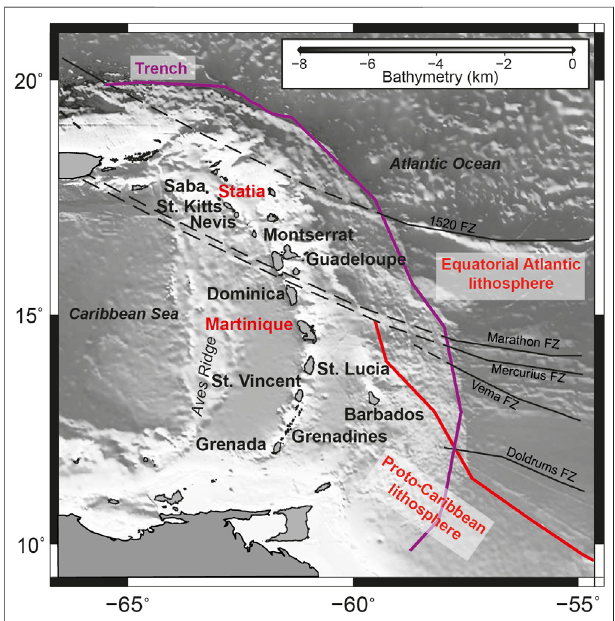
FIGURE 1 | Bathymetric map of the Lesser Antilles. The locations of Statia (northern LAA) and Martinique (central LAA) sampled for this study are shown in red text. The boundary (red line) between the proto-Caribbean and equatorial Atlantic sea fl oor is shown (Map adapted from Cooper et al.,